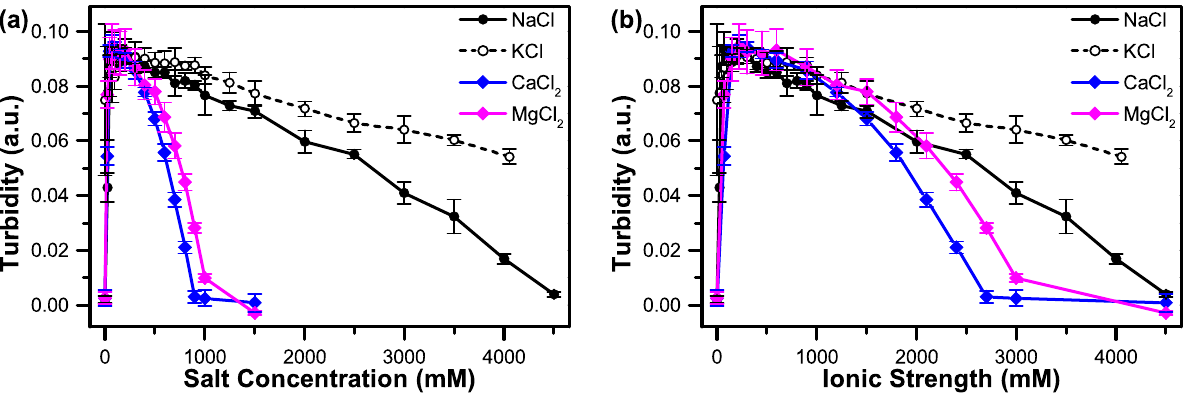
Figure 6. Plots of turbidity as a function of ( a ) salt concentration and ( b ) ionic strength for a series of chloride salts, investigating the effects of various cations. All samples were prepared at 1 mM total monomer concentration, 50/50 mol% pAA/pAH ratio at pH 6.5. Complexes were prepared by adding pAA to a solution containing a mixture of pAH and the desired quantity of